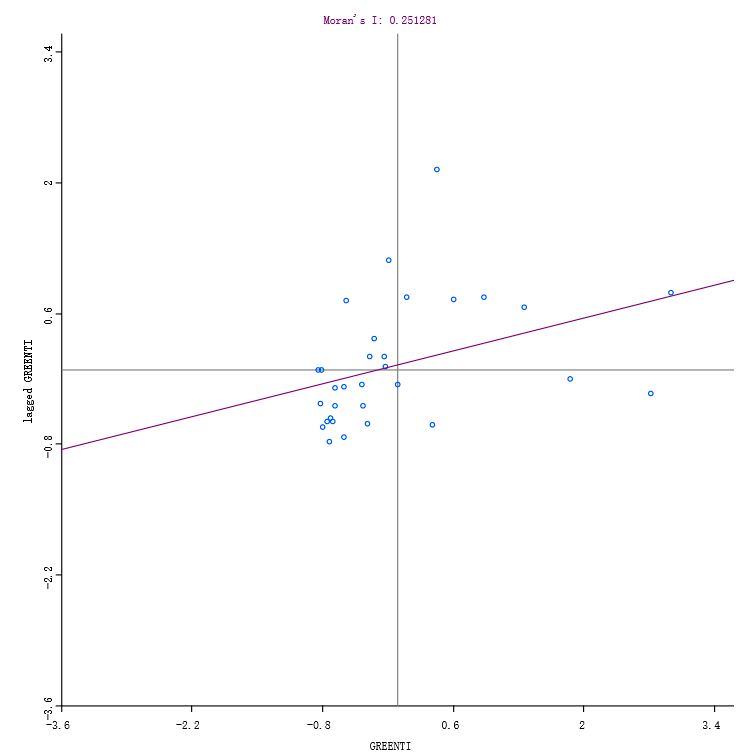
Figure 3. Scatter diagram of Moran’s I in 2016.